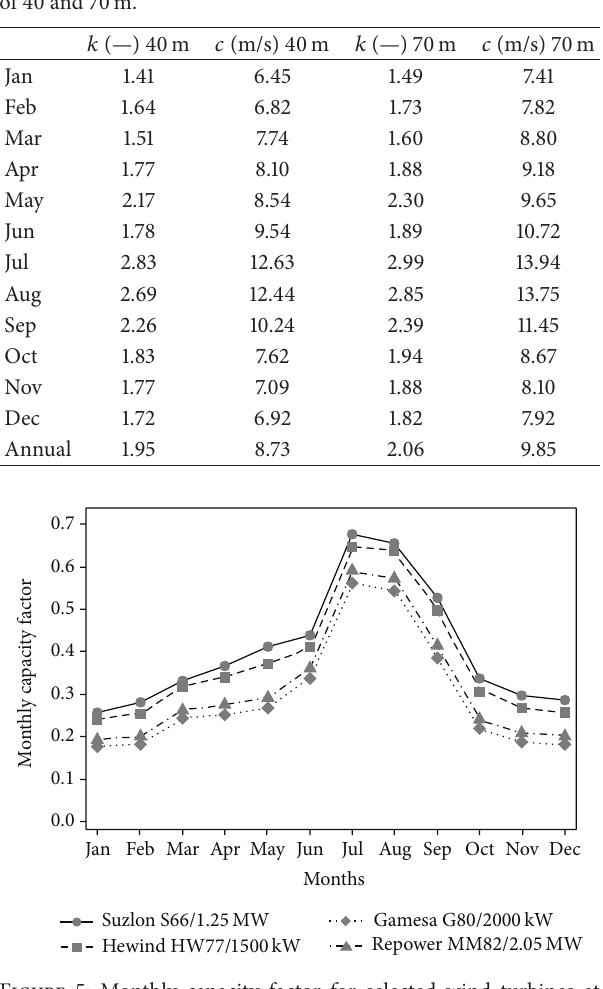
Table 1: Monthly and annual shape and scale parameters at heights of 40 and 70 m.